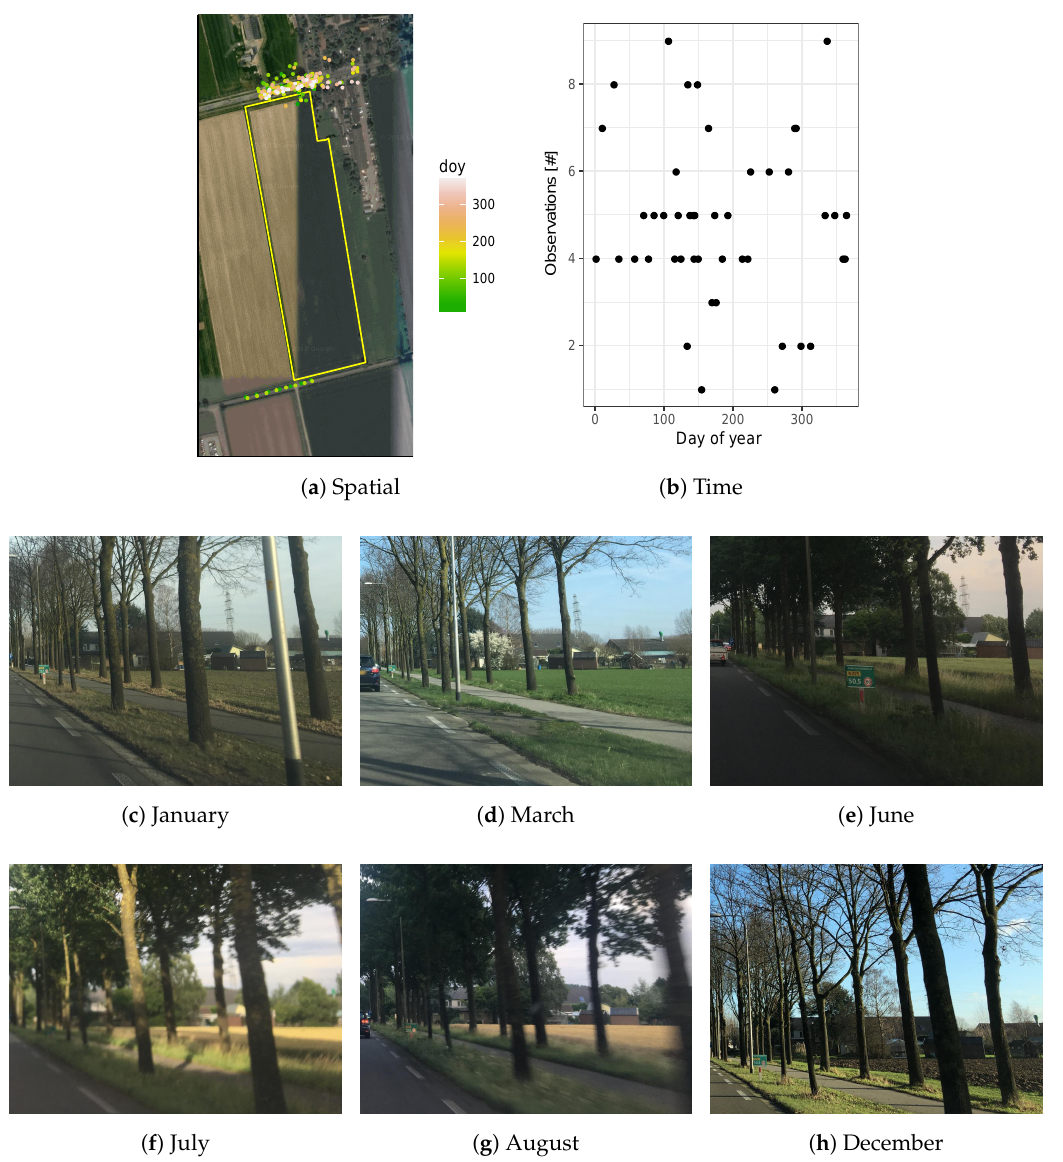
Figure 12. In 2017, this parcel (latitude = 51.9567 ◦ N, longitude = 5.6345 ◦ E) was observed 222 times on 46 unique days. The average revisit rate is 4.8 days. Having frequent pictures permits to observe several winter wheat growth